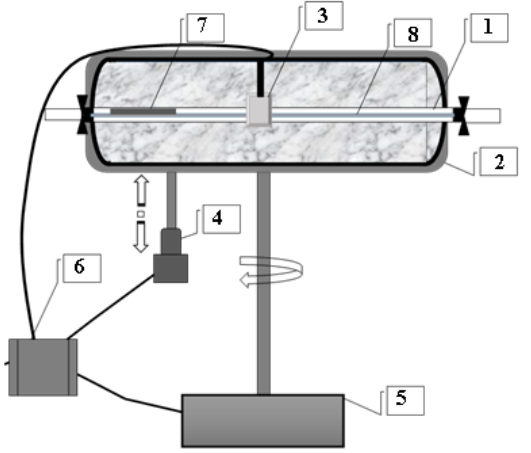
Figure 2: Schematic diagram of pilot scale CPC with tracking system reactor; 1- quartz tube (with inlet and outlet valves), 2 - CPC, 3 - photo sensor, 4 - Vertical rotator, 5 - Horizontal rotator, 6 - Controller , 7 - Thermometer, 8 - Copper